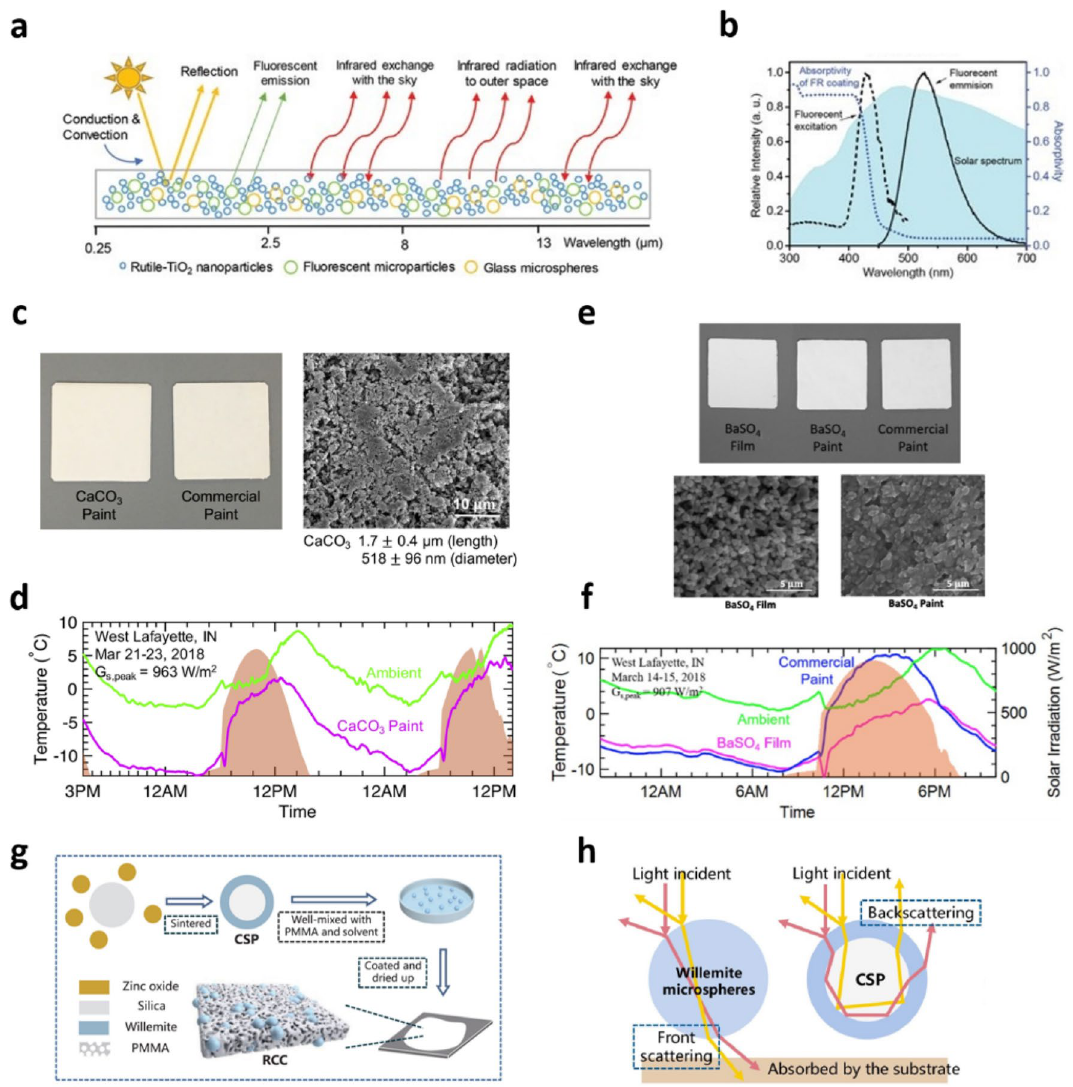
Fig. 3 a Schematics of PDRC film composed of NPs and MPs acting as solar reflectors, fluorescent particles, and IR emitters in polymer